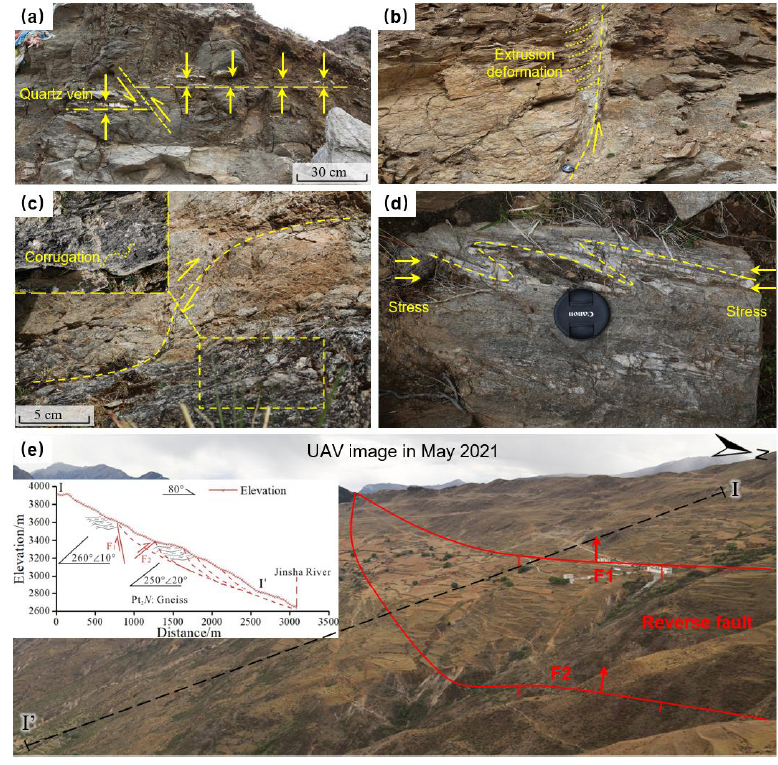
Figure 17. Characteristics of surface fault activity within the Xiongsong landslide. Locations of fea- tures ( a – d ) are shown as points in Figure 16 (P1 – P4). (e) shows the UAV image and geological profile of the landslide. features ( a – d ) are shown as points in Figure 16 (P1–P4). ( e ) shows the UAV image and geological profile of the